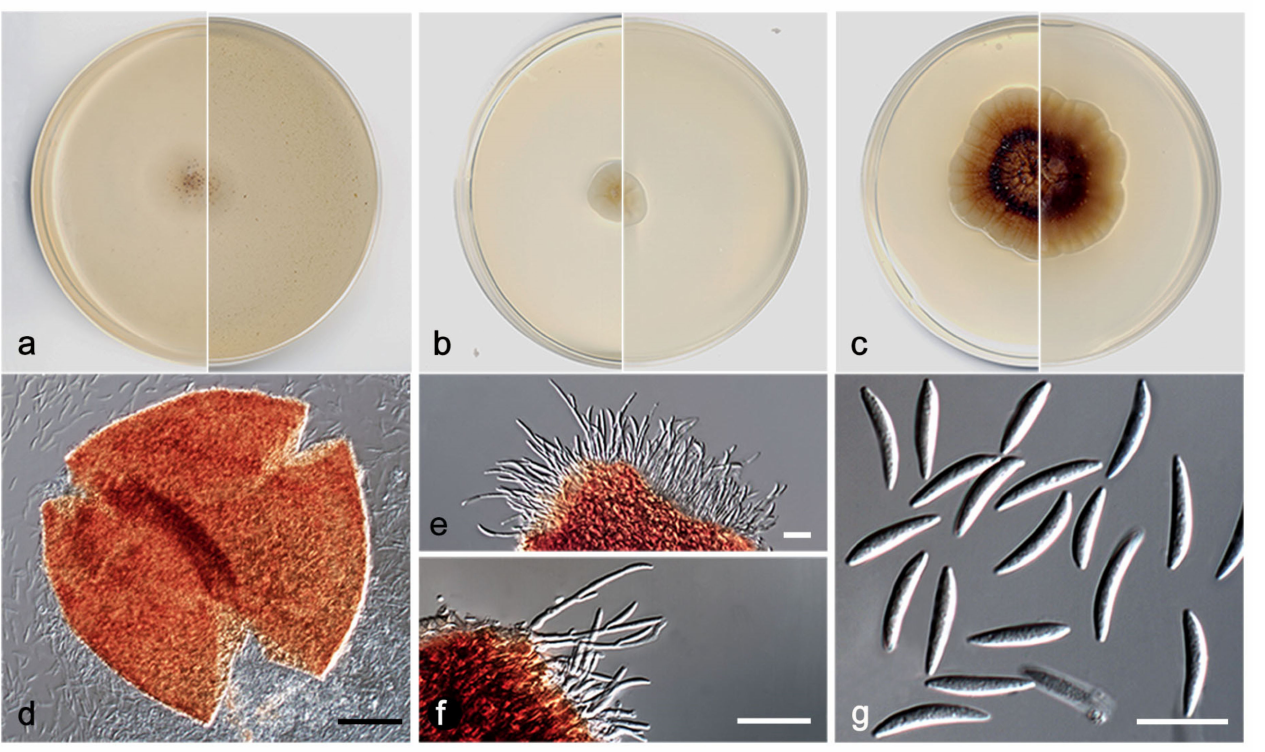
Figure 12. Pilidium cuprescens FMR 17839 ( a ) Colonies on OA ( b ) MEA ( c ) and PDA after two weeks at 25 ± 1 ◦ C (surface, left; reverse, right); ( d ) Pycnidium; ( e , f ) Conidiophores; ( g ) Conidia. Scale bars: ( d ) = 50 µ m, ( e – g ) = 10 µ